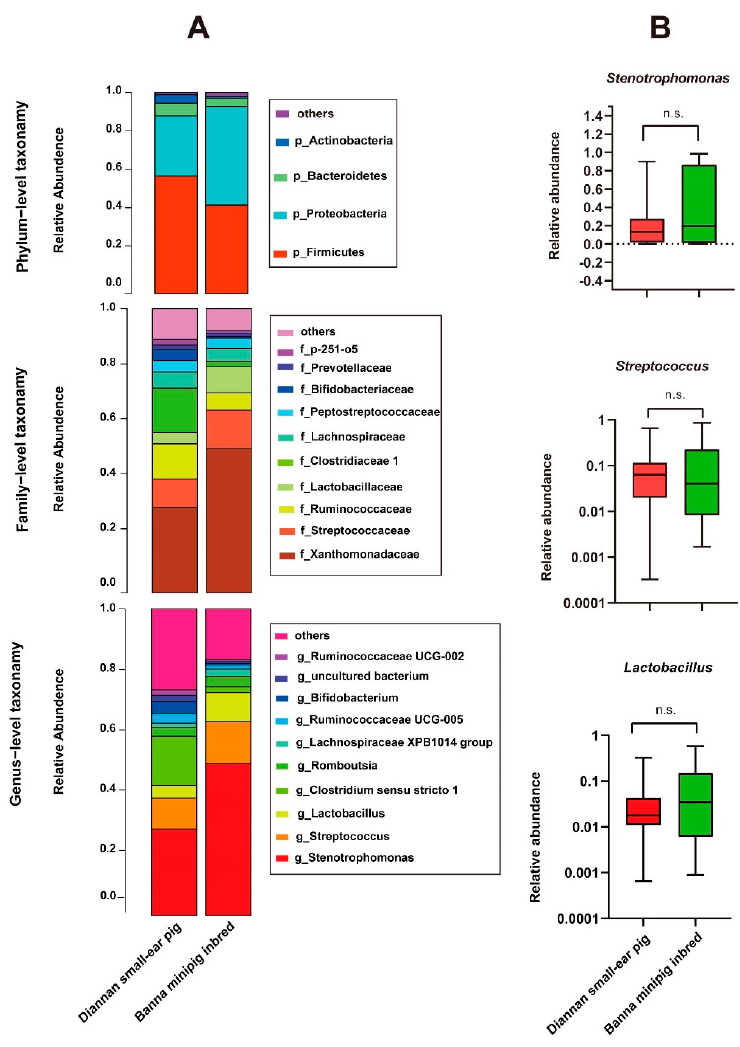
Figure 2. ( A ) The phylum, family, and genus classification of the 16S rRNA gene sequences in Diannan small-ear pig and Banna minipig inbred. ( B ) Distributions of relative abundances are shown as box plots for gut microbiota that was no significant changes in the two groups. n.s., no significance, Mann–Whitney U-test.